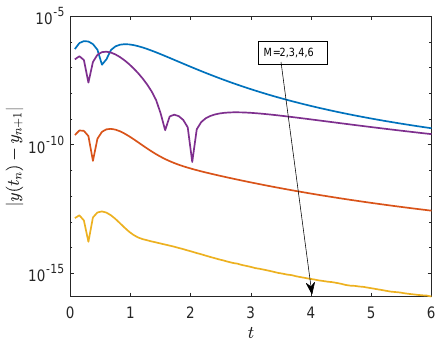
Figure 6. Errors for example 3.